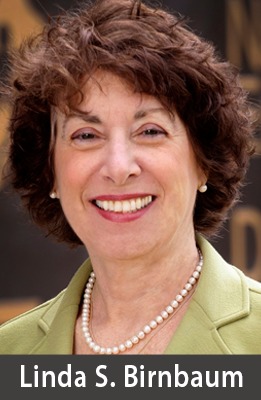
Linda S. Birnbaum